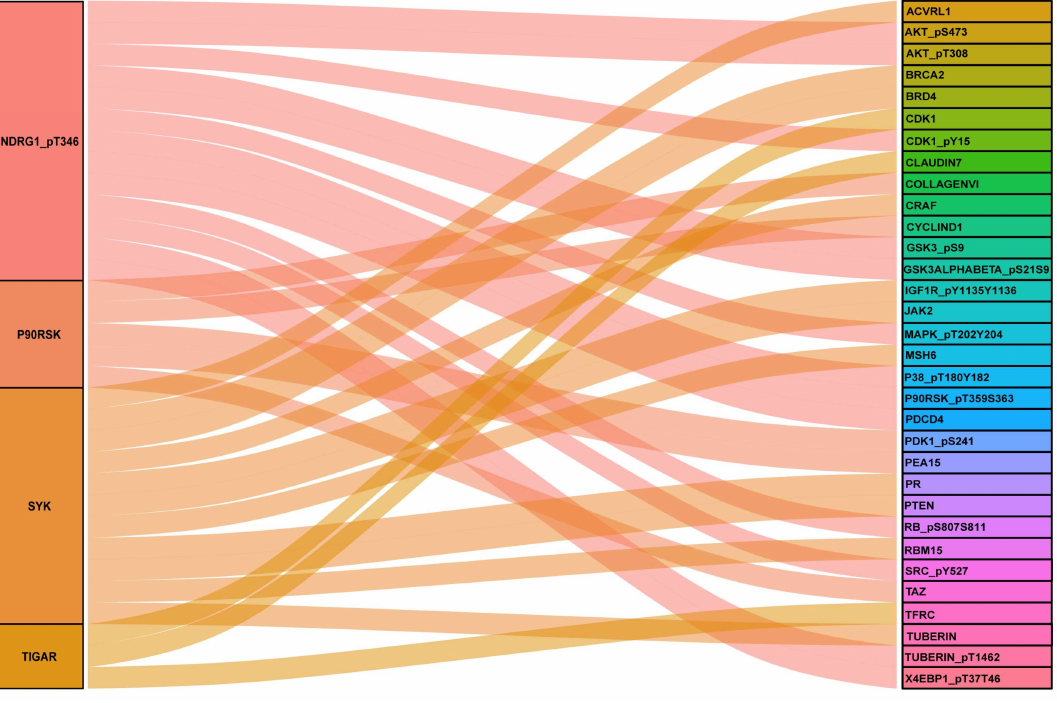
Figure 4. Correlation analyses between model proteins and other proteins based on the TCPA